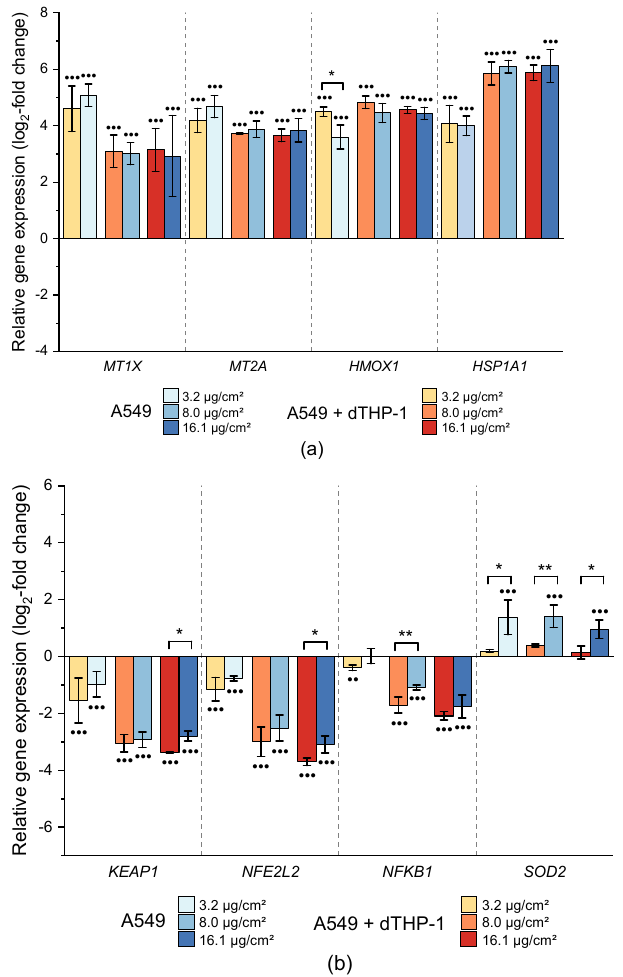
Figure 6. Impact of CuO NP on genes related to metal homeostasis and oxidative stress response in A549 monoculture (A549) and co-culture (A549+dTHP-1) after 24 h incubation. ( a ) Expression of genes related to metal homeostasis and transcriptional oxidative stress markers; ( b ) expression of genes associated with anti-oxidative defense mechanisms. Depicted is the log 2 -fold change of at least three independently conducted experiments ± SD. Significantly different from negative controls: ● ≤ 0.05, ●● ≤ 0.01, ●●● ≤ 0.001 (ANOVA-Dunnett’s t -test); significantly different between cell models: * ≤ 0.05, ** ≤ 0.01, *** ≤ 0.001 (unpaired t -test).